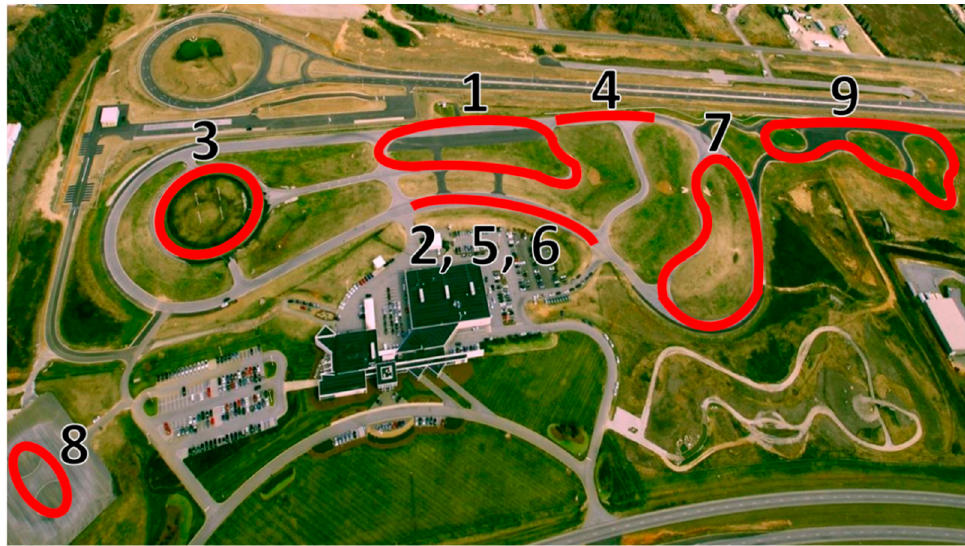
Figure 1. Locations of exercises on the closed-road track. The numbers correspond with the exercises described in Table